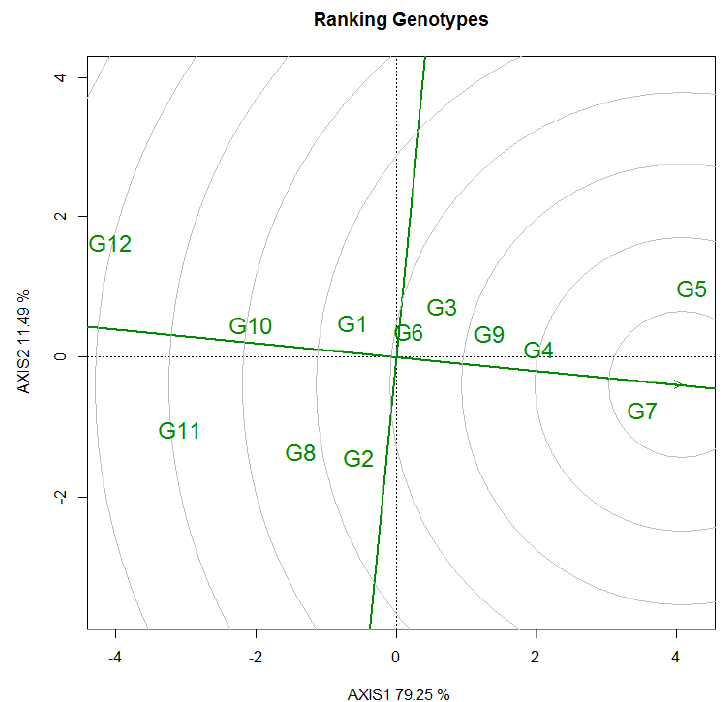
Figure 6. Ranking genotypes of tree height. The smaller the radius of the concentric circles, the higher the ranking of the genotypes for comprehensive high yield and stability.